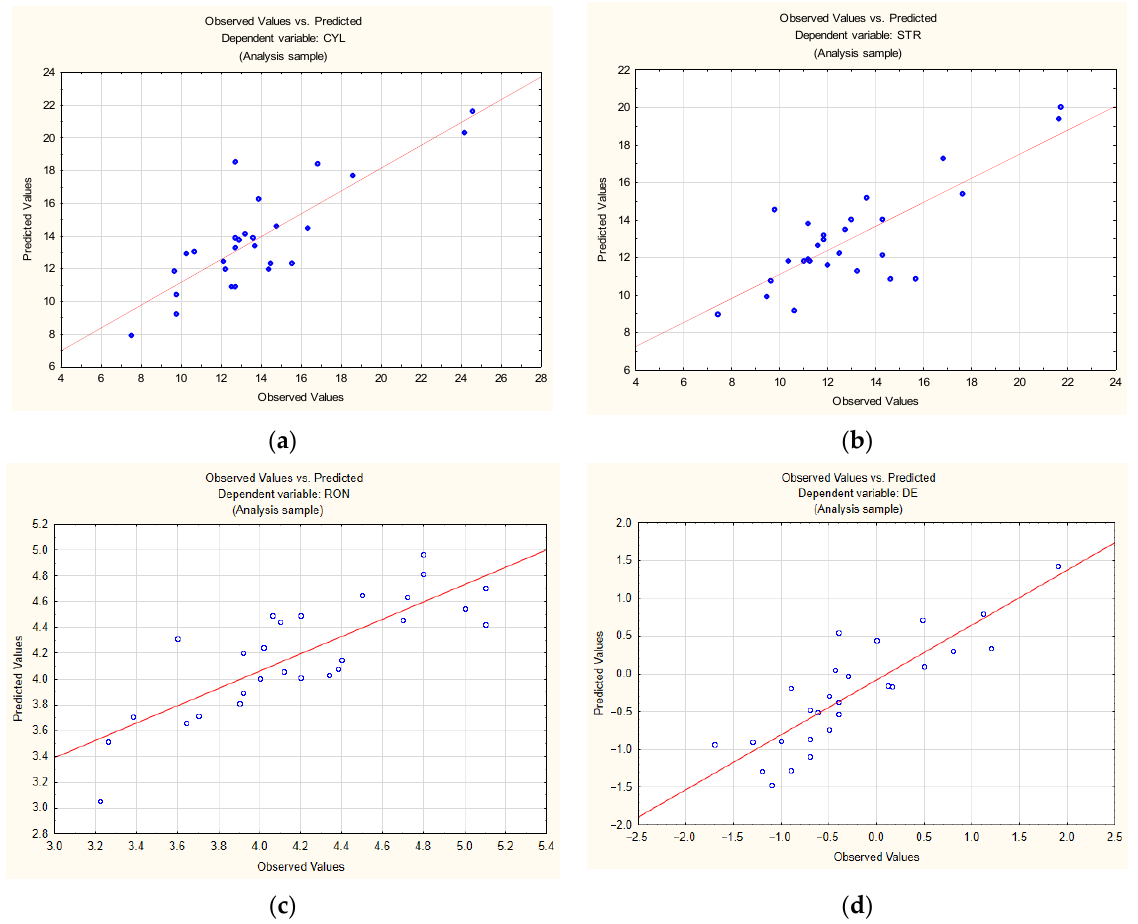
Figure 4. Experimental values vs. predicted values for: ( a ) cylindricity error; ( b ) straightness error; ( c ) roundness error; ( d ) diameter error.